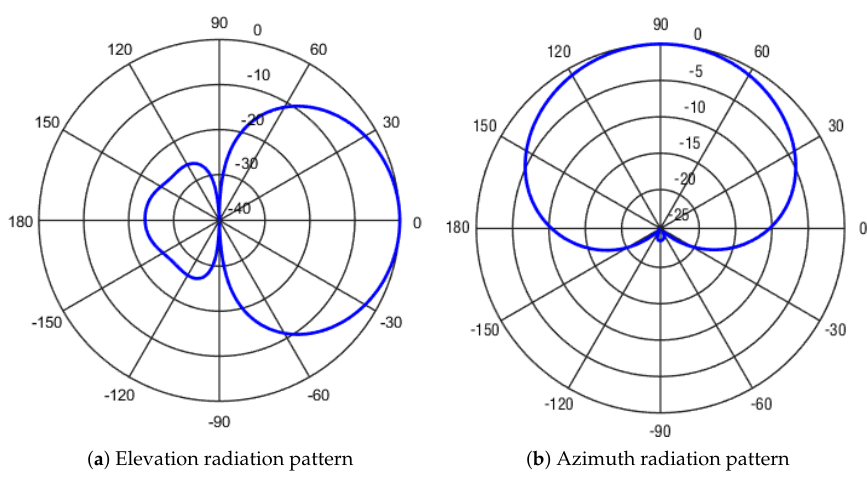
Figure 6. Televés 4G NOVA antenna radiation pattern generated using ANSYS